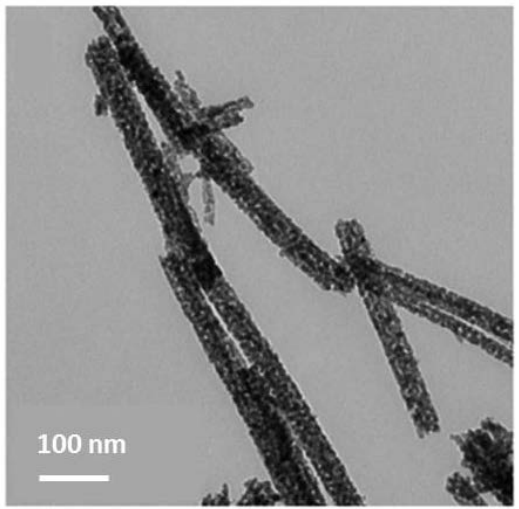
Figure 9. TEM image of CdS-ZnS supported on TiO 2 (Adapted with permission from [79]. Copyright the Royal Society of Chemistry, 2015).